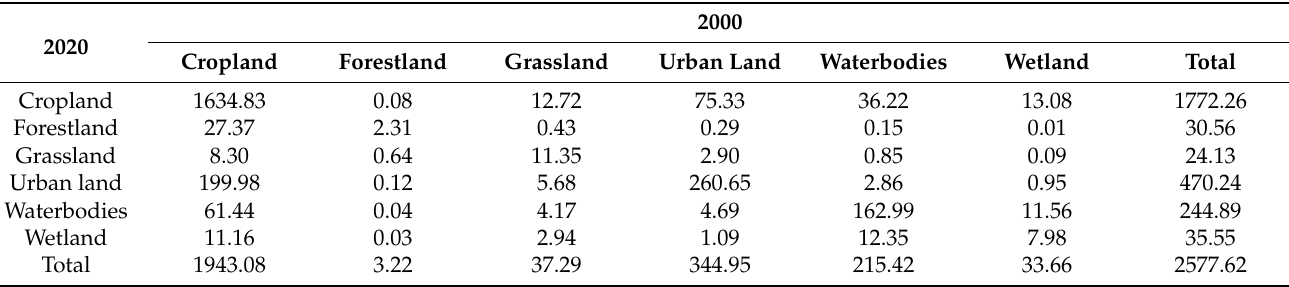
Table 3. Huainan land-use change matrix (km 2 ).